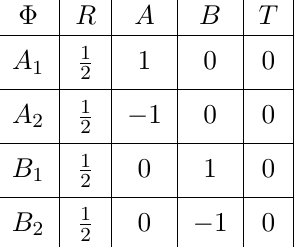
Table 1 . Charge assignments of N = 2 chiral multiplets in the ABJM theory. The U (1) T symmetry acts non-trivially on monopole